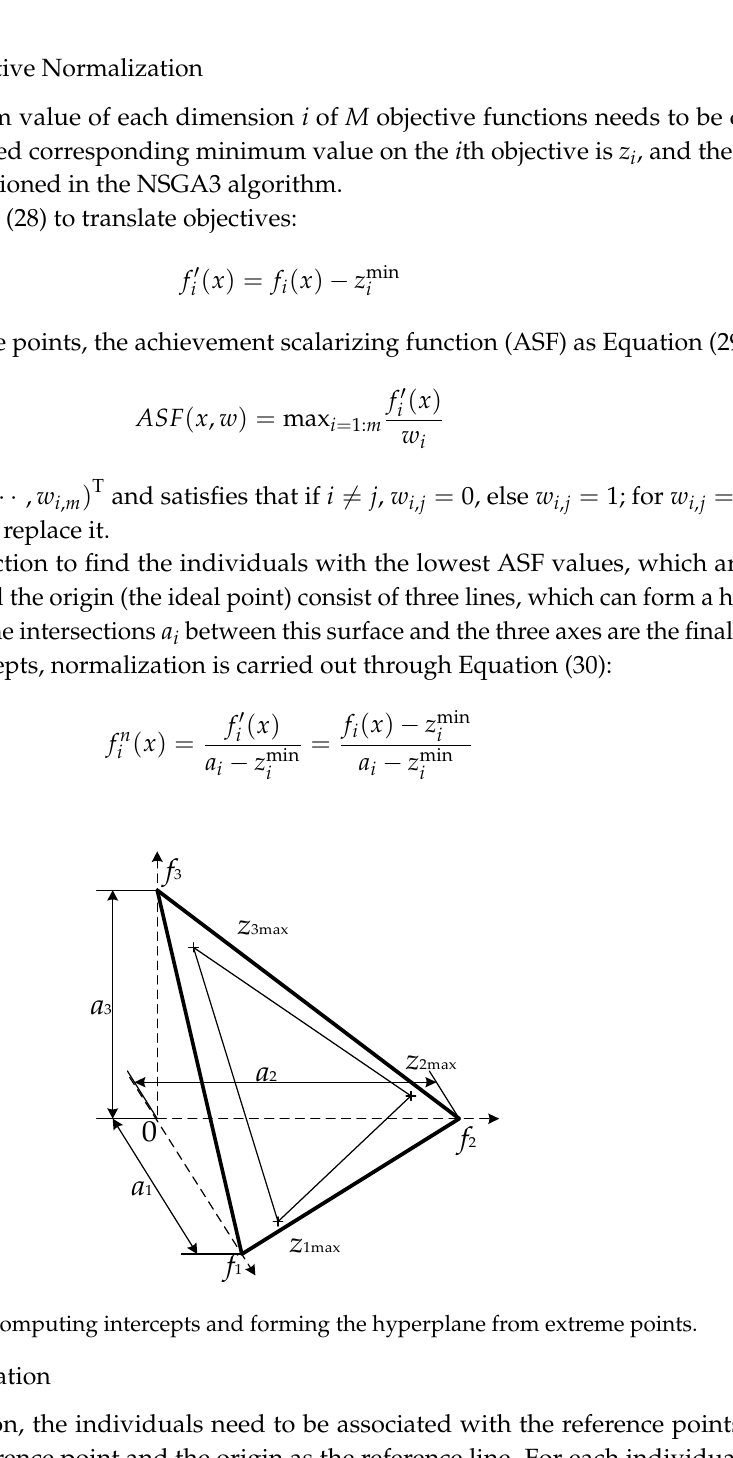
Figure 3 . Reference points on a hyperplane.